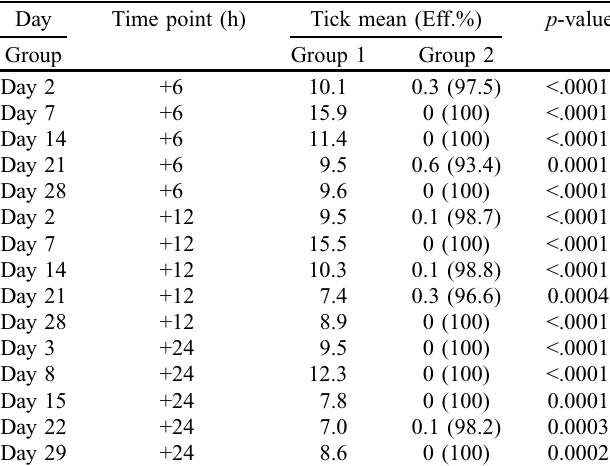
Table 3. Efficacy against Ixodes ricinus (arithmetic means).